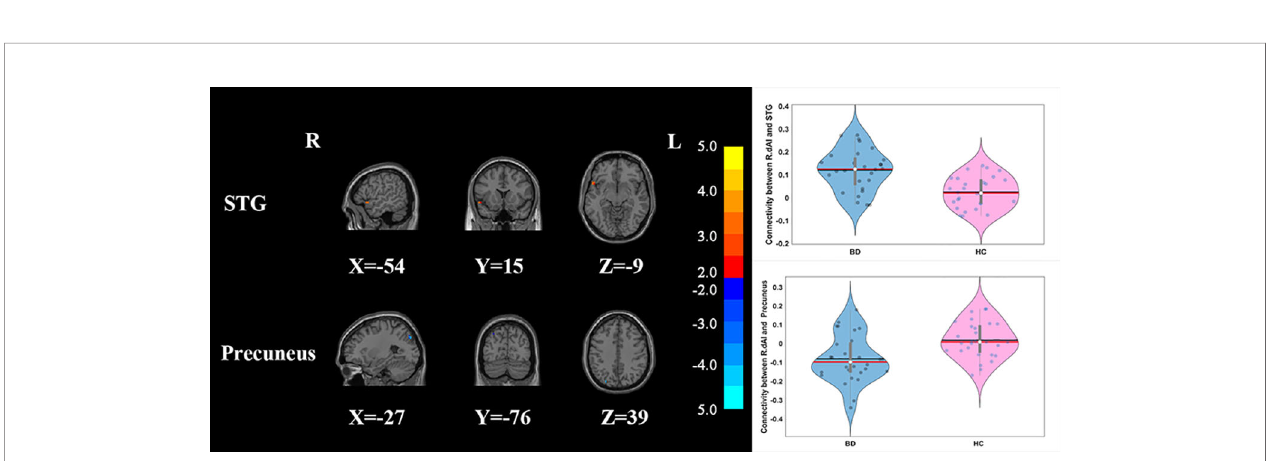
FIGURE 3 | Group differences of the whole-brain functional connectivity anchored in R_dAI: while showing decreased functional connectivity between R_dAI and precuneus, BD patients had signi fi cantly higher functional connectivity between R_dAI and STG compared to HCs (GRF corrected, p < 0.05, voxel Z value > 2.3). Blue indicates smaller values in BD and red indicates larger values in BD. L, left; R, right; BD, bipolar disorder; HC, healthy control; R_dAI, right dorsal anterior insula; STG, superior temporal gyrus; GRF, Gaussian random fi